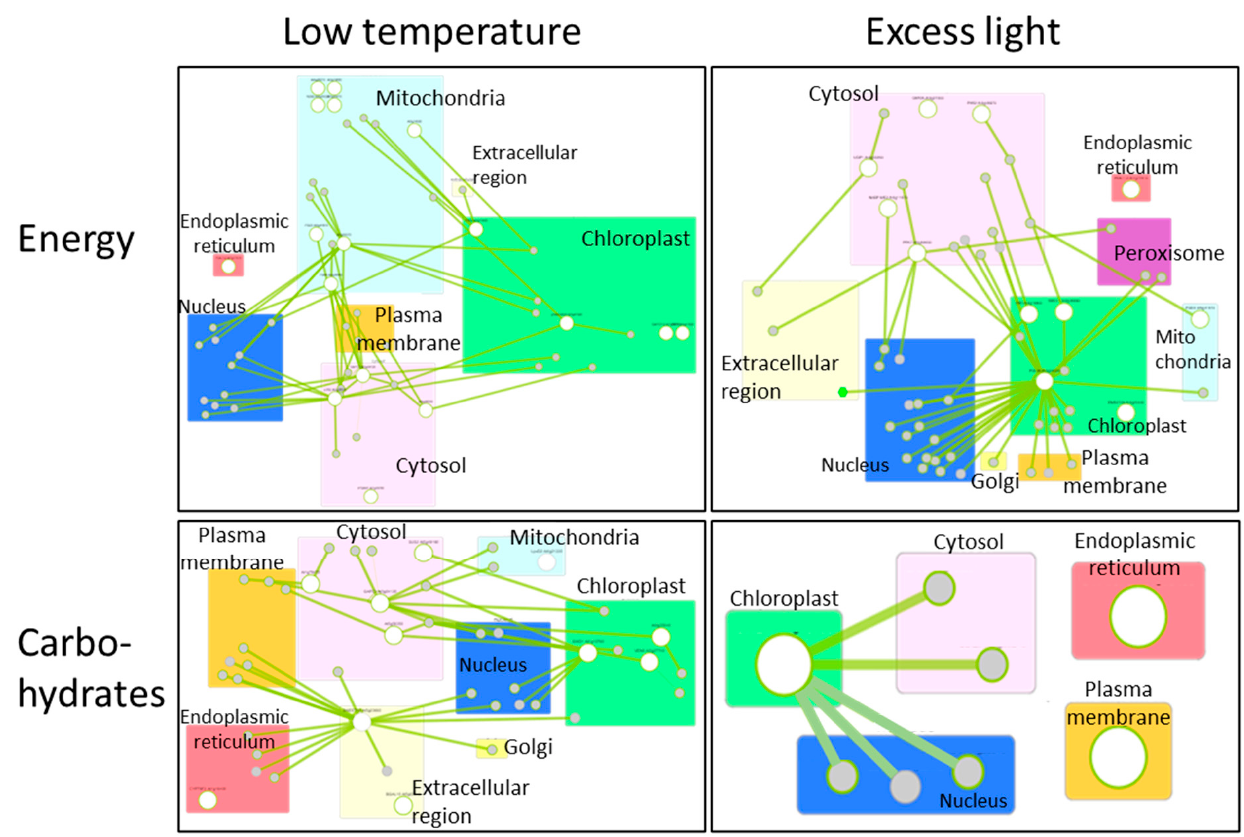
Figure 3. Molecular networks activated in plant cells, in response to low temperature ( left ) or excess light ( right ). Lists of genes up-regulated in response to low temperatures or excess light were obtained from a previous study in which alterations in the activities of genes were comprehensively analyzed in plants subjected to low temperature or excess light [92]. Genes involved in production/usage of energy (upper panels) and carbohydrate metabolisms (lower panels) were then picked up from the lists of low temperature or excess light responsive genes based on the information from the database, Gene Ontology Resources (http://geneontology.org/ accessed on 15 January 2021). These genes were then analyzed in the network using the database, Arabidopsis Interaction Viewer 2.0 (http://bar.utoronto.ca/interactions2/ accessed on 15 January 2021). In this database, links between genes of interest can be automatically detected based on the information from hitherto studies, and figures indicating gene networks can be generated. Large white circles indicate genes in the list of low temperature or excess light responsive genes [92] analyzed by the database. Small gray circles indicate genes that were not in the list but detected as genes linked to large white circle genes. Rectangles with different colors indicate different cellular components. Green lines indicate the links between genes.